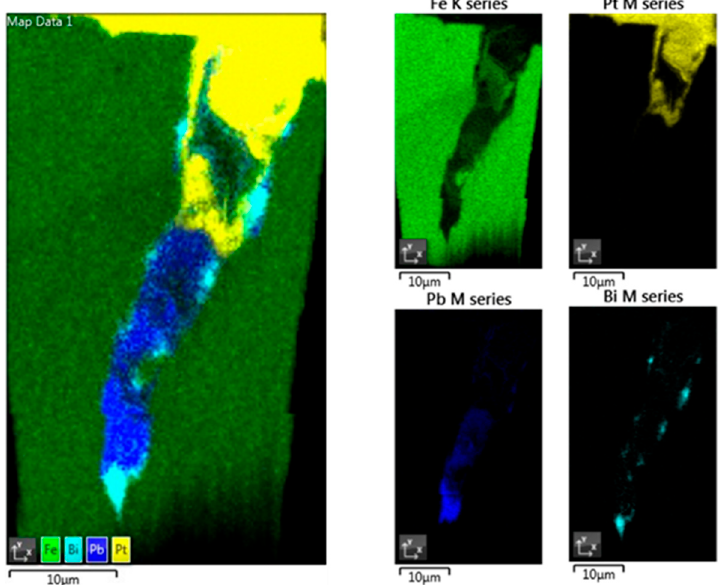
Figure 4. EDS X-ray layered elemental map showing the penetration of LBE into the crack in the T91 specimen and elemental maps for Fe, Pt (coming from the cross-section sample preparation), Pb and Bi of the area around the crack tip.